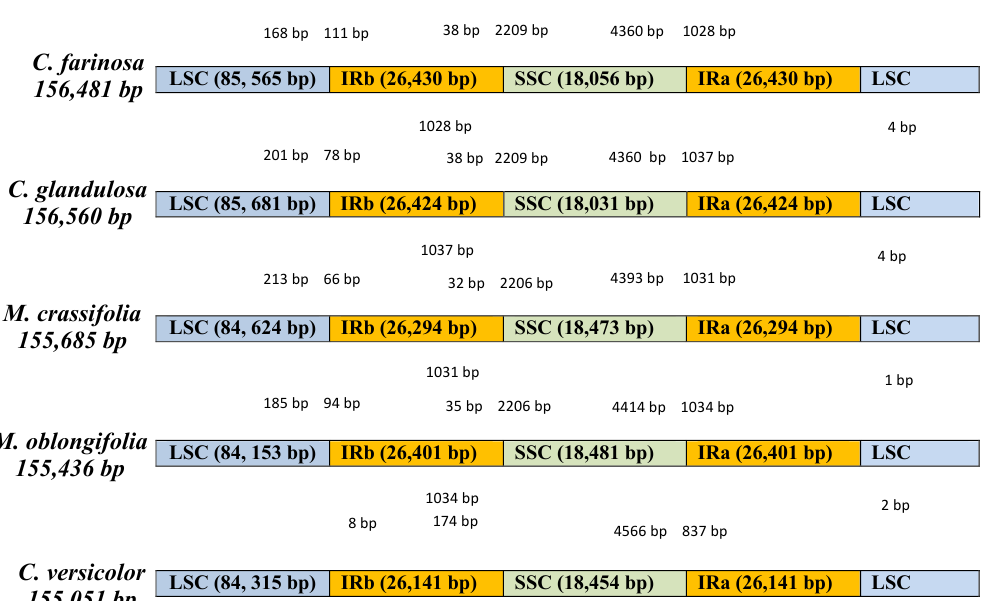
Figure 6. Alignment of chloroplast genomes of C. farinosa , C. glandulosa , M. crassifolia, M. oblongifolia and C. versicolor performed with C. farinosa as reference. Transcription direction is indicated by the gray arrows at the top, protein coding is represented by blue bars, non-coding sequence CNS is represented by pink bars and tRNAs and rRNAs are represented by light green. The cp genome is identified by the coordinates in the x-axis, while the y-axis represents the percentage identity within 50–100%.